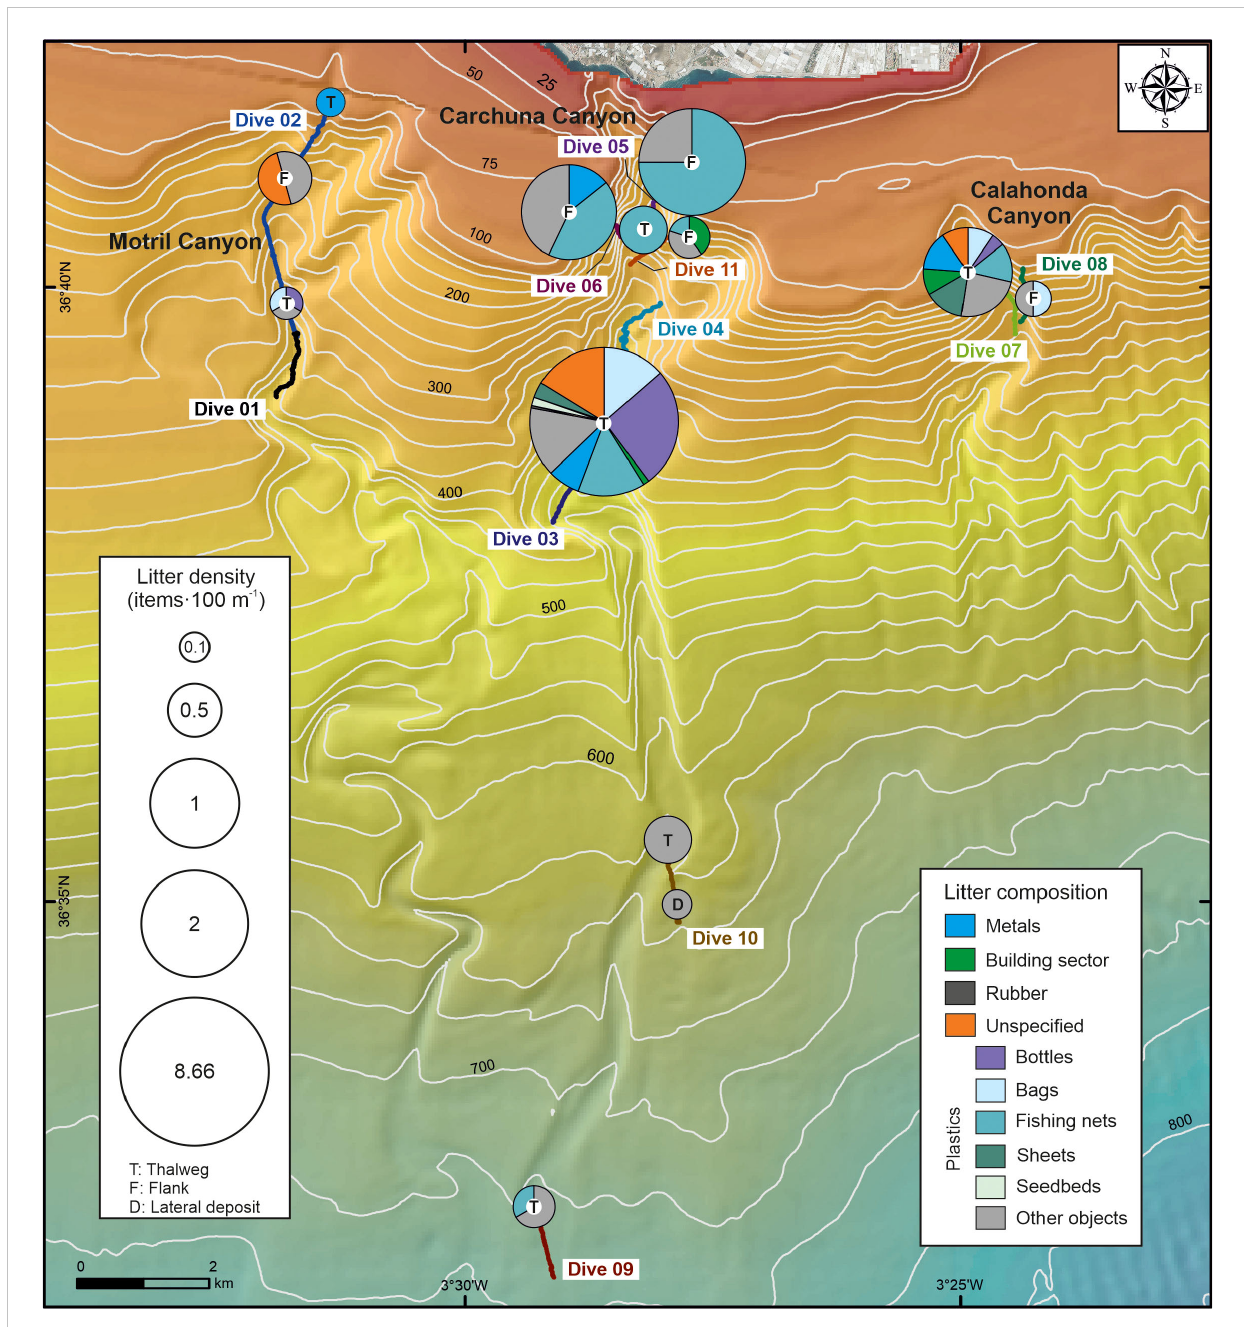
FIGURE 4 Spatial distribution and composition of marine litter along the canyon thalwegs and fl anks of the three studied submarine canyons. The size of the pie charts is proportional to the abundance of litter (expressed as number of items·100 m -1 ). The maximum litter density (8.66 items·100 m -1 ) was found in the thalweg of the Carchuna Canyon. Bathymetric contours in